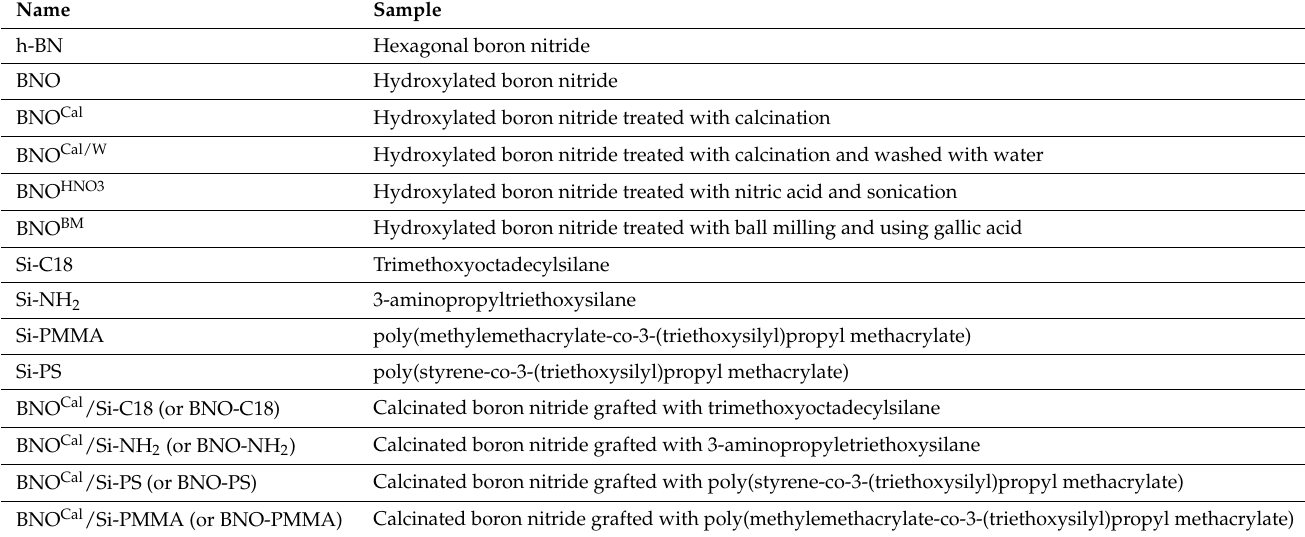
Table 1. List of abbreviations for the different products used in this